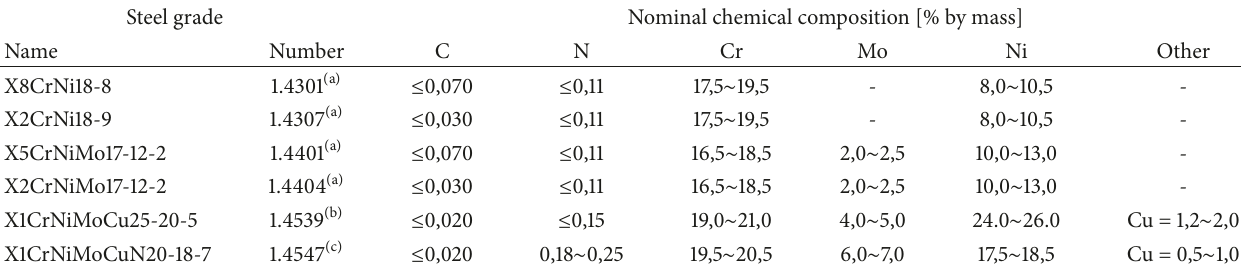
Table 1: Chemical composition of selected stainless steels according to EN 10088-1 standard